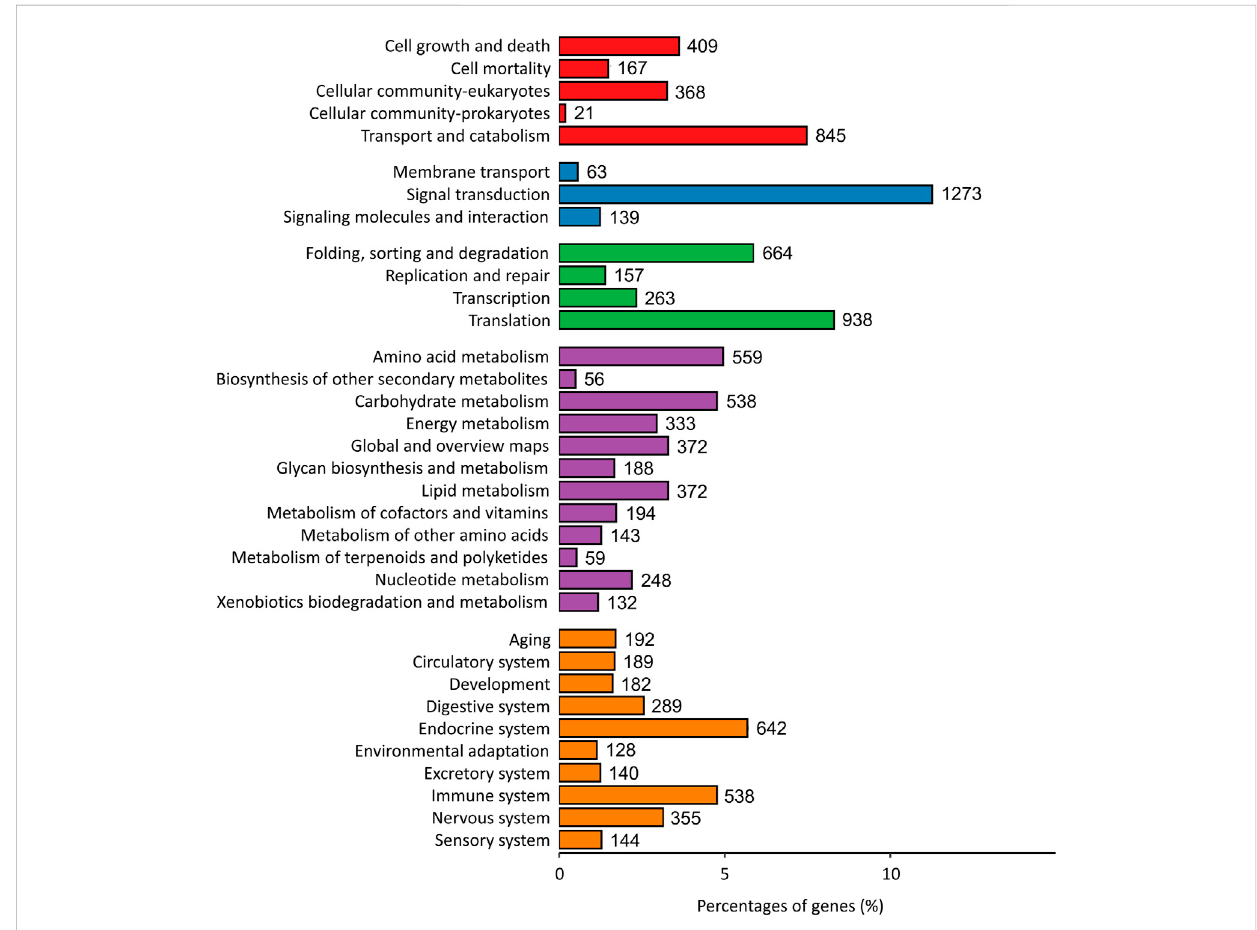
FIGURE 2 KEGG metabolic pathway classi fi cation. Annotated genes were assigned into one of fi ve categories based on predicted function (Red bar: Cellular Processes; Blue bar: Environmental Information Processing; Green bar: Genetic Information Processing; Purple bar: Metabolism; Orange bar: Organismal